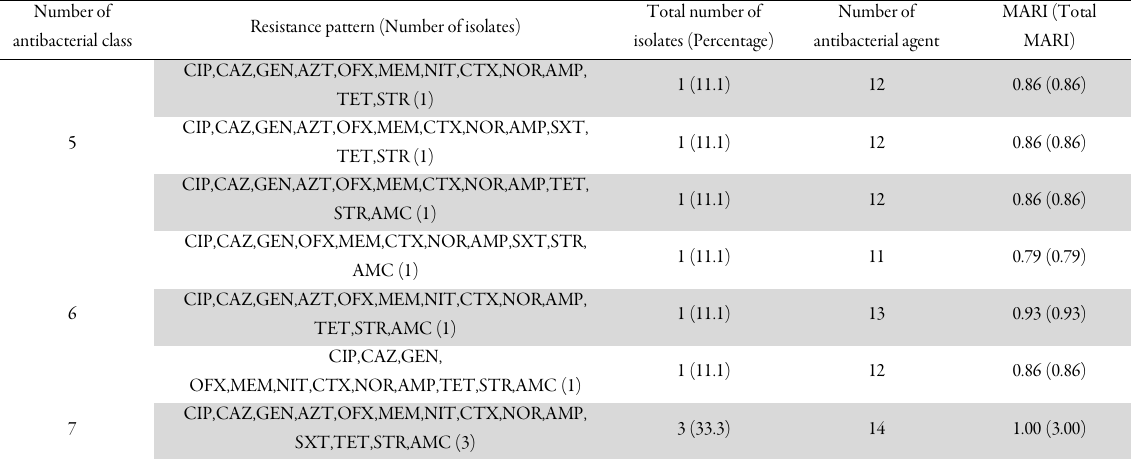
Table 2. Multiple antibacterial resistance profiles, patterns and indices of 9 generic faecal Salmonella isolates from healthy adults in Ankpa Northcentral Nigeria Number